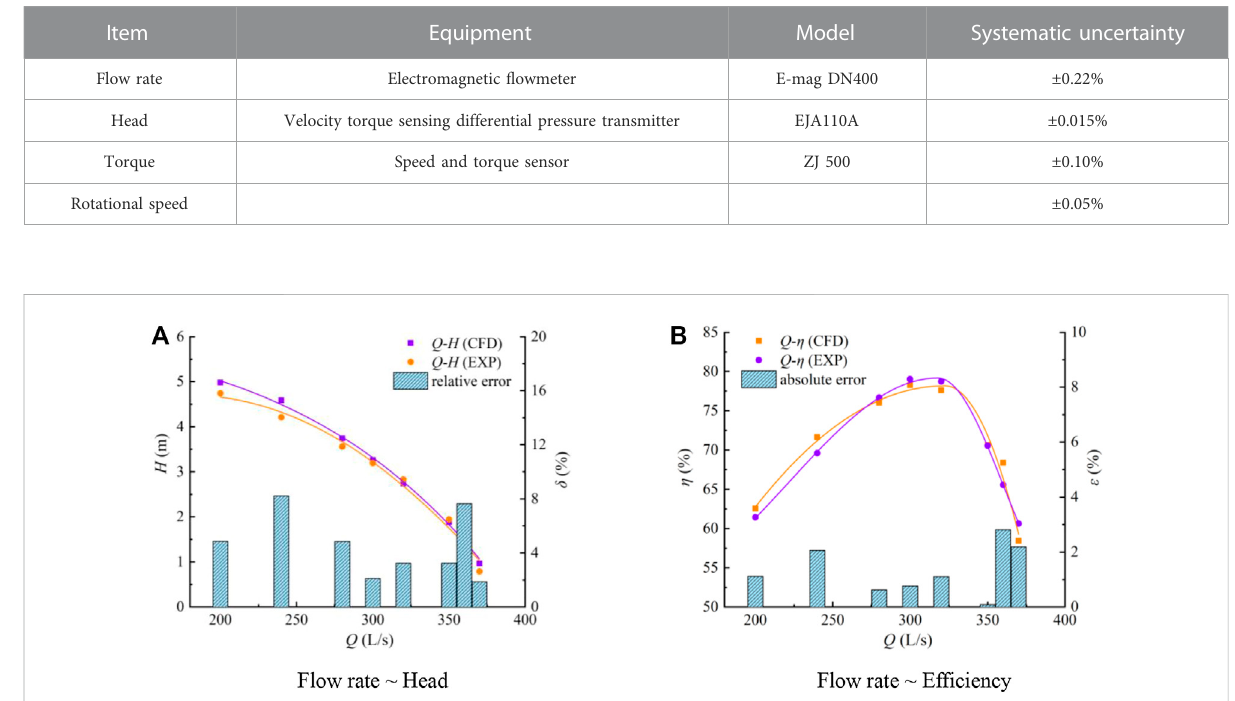
TABLE 3 Systematic uncertainty of the test equipment.